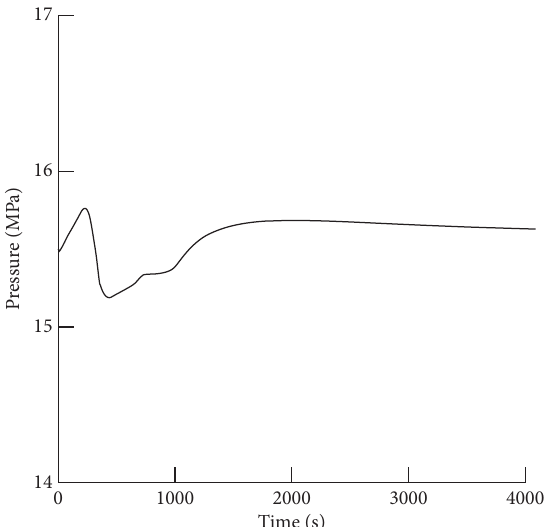
Figure 10: Heat transfer power of the